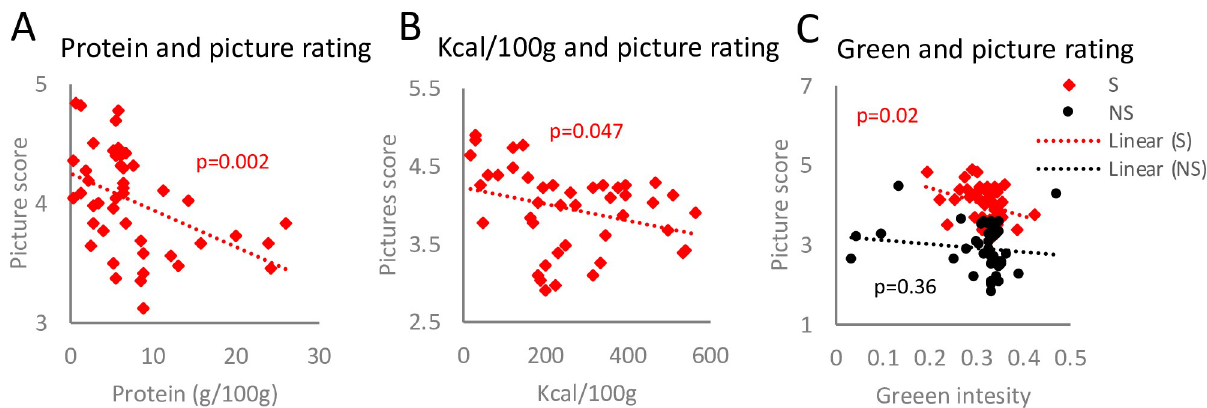
Fig 4. Participants’ preference towards pictures showing low protein, low calorie-dense foods with low green colour intensity. Linear regression was applied to analyse interconnection between pictured food protein content and corresponding rating (A), caloric content per 100g of the shown food and picture score (B) as well as the intensity of green colour and picture evaluation (C).